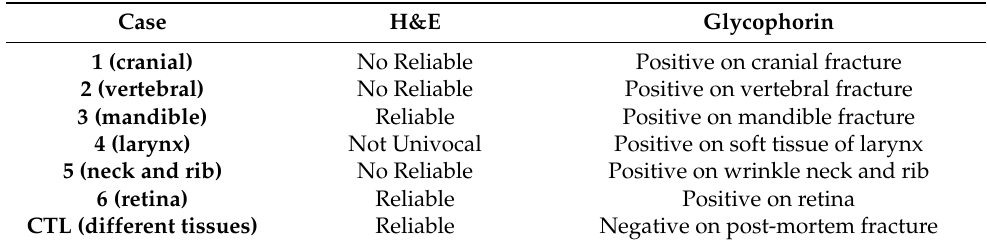
Table 2. The main results of the histological and immunoistochemical examination.